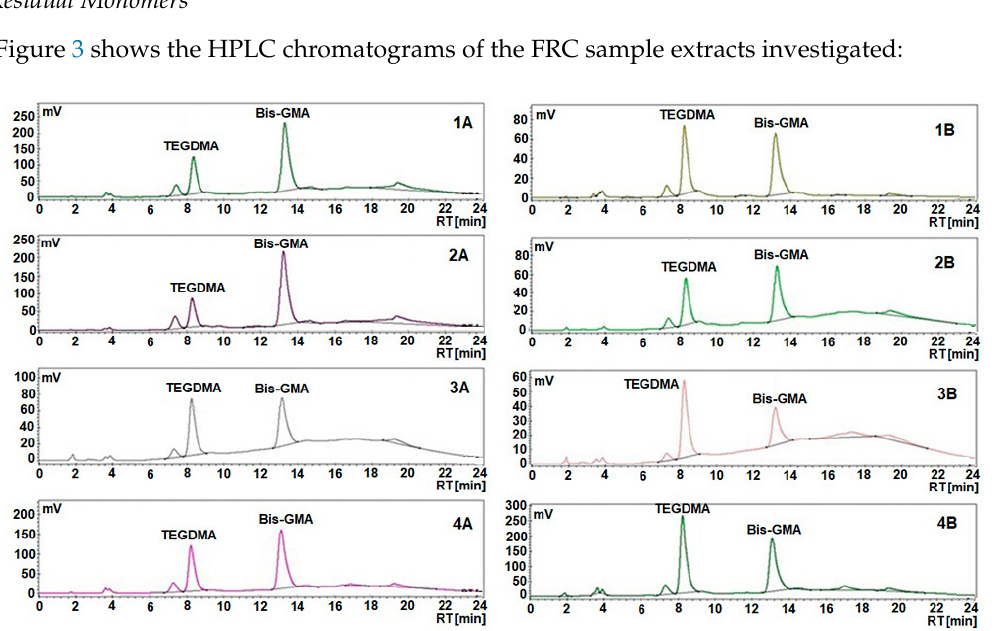
Figure 3. HPLC chromatogram of residual monomers from the FRC extracts samples.